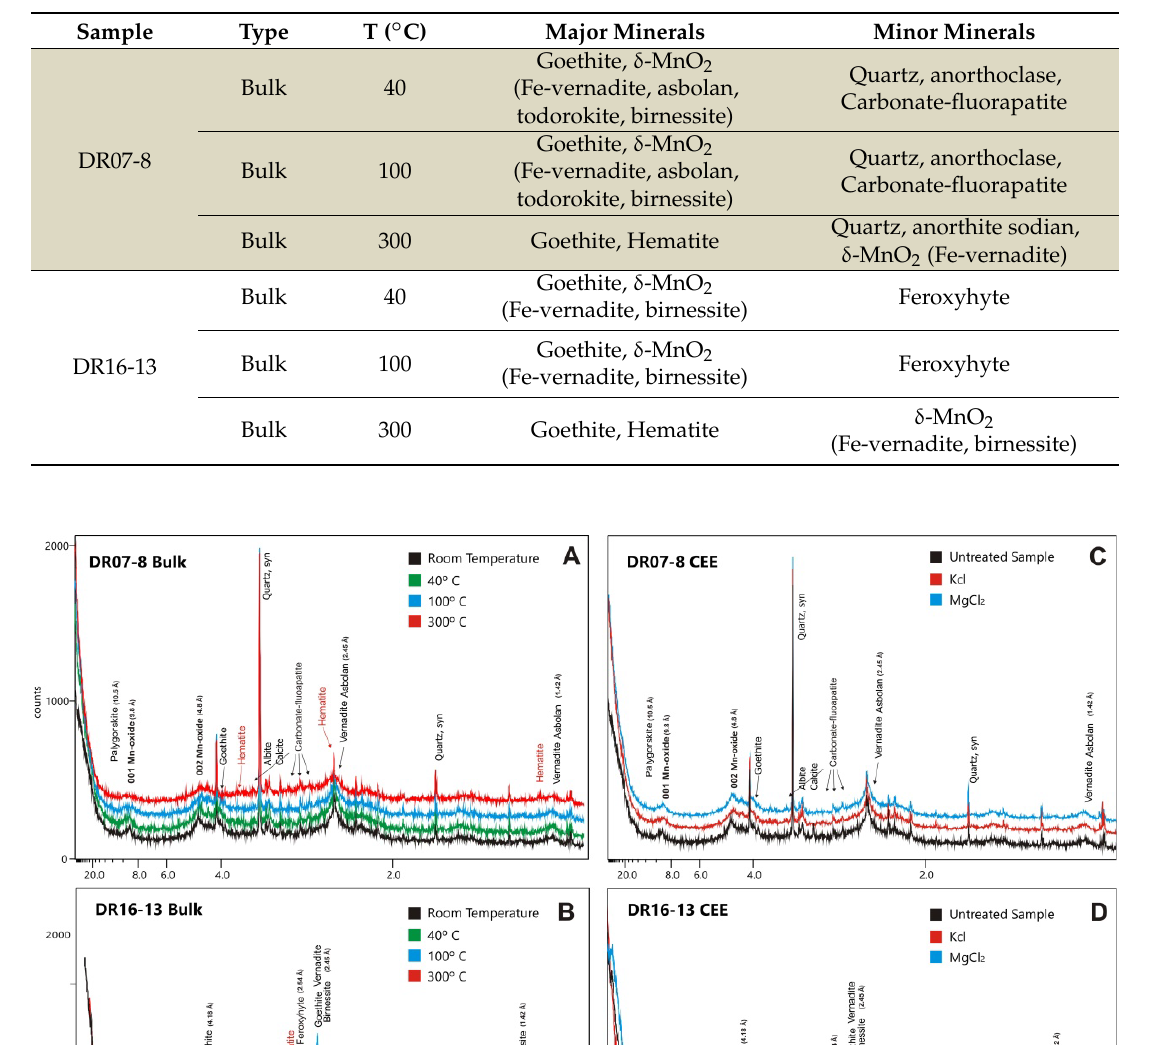
Table 1. XRD mineralogy of crystalline phases from CISP Fe–Mn crusts DR07-8 and DR16-13. Major > 25%; Minor < 10%. The back color is to differentiate both samples.